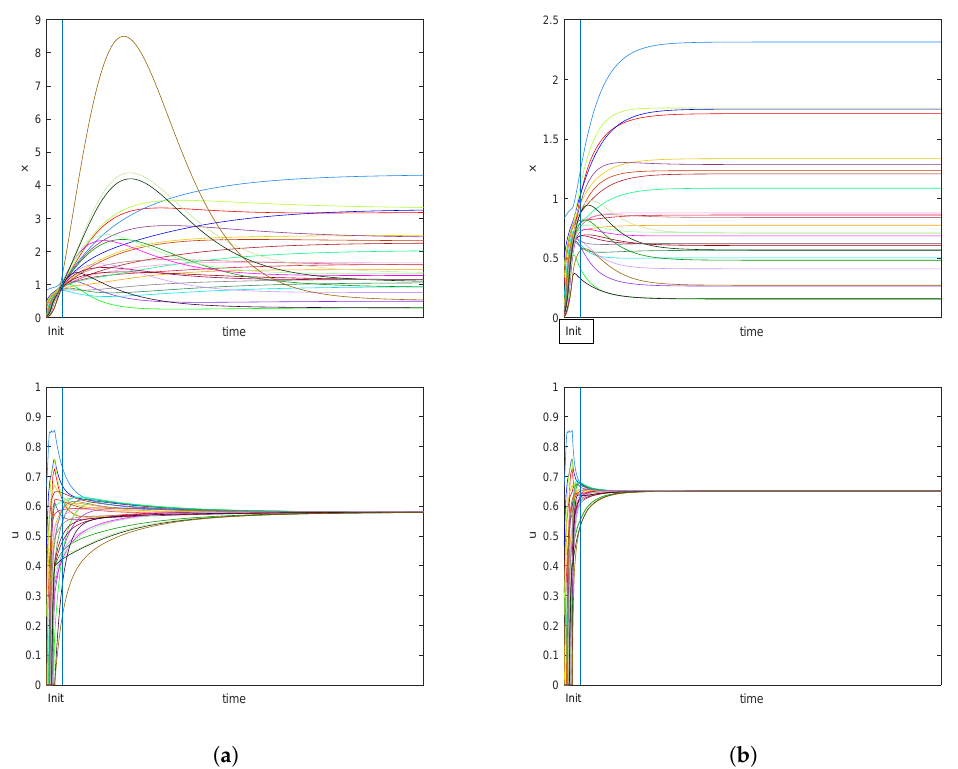
Figure 6. Pollution stock x and investment u into environmentally friendly policies for each player with both a basic and more advanced imitation behavior with a long initial phase in which all players minimize their individual costs. All results are obtained with the same initial conditions such as the initial values for x i ( 0 ) . ( a ) Basic imitation behavior after a long initial phase; ( b ) More advanced imitation behavior after a long initial